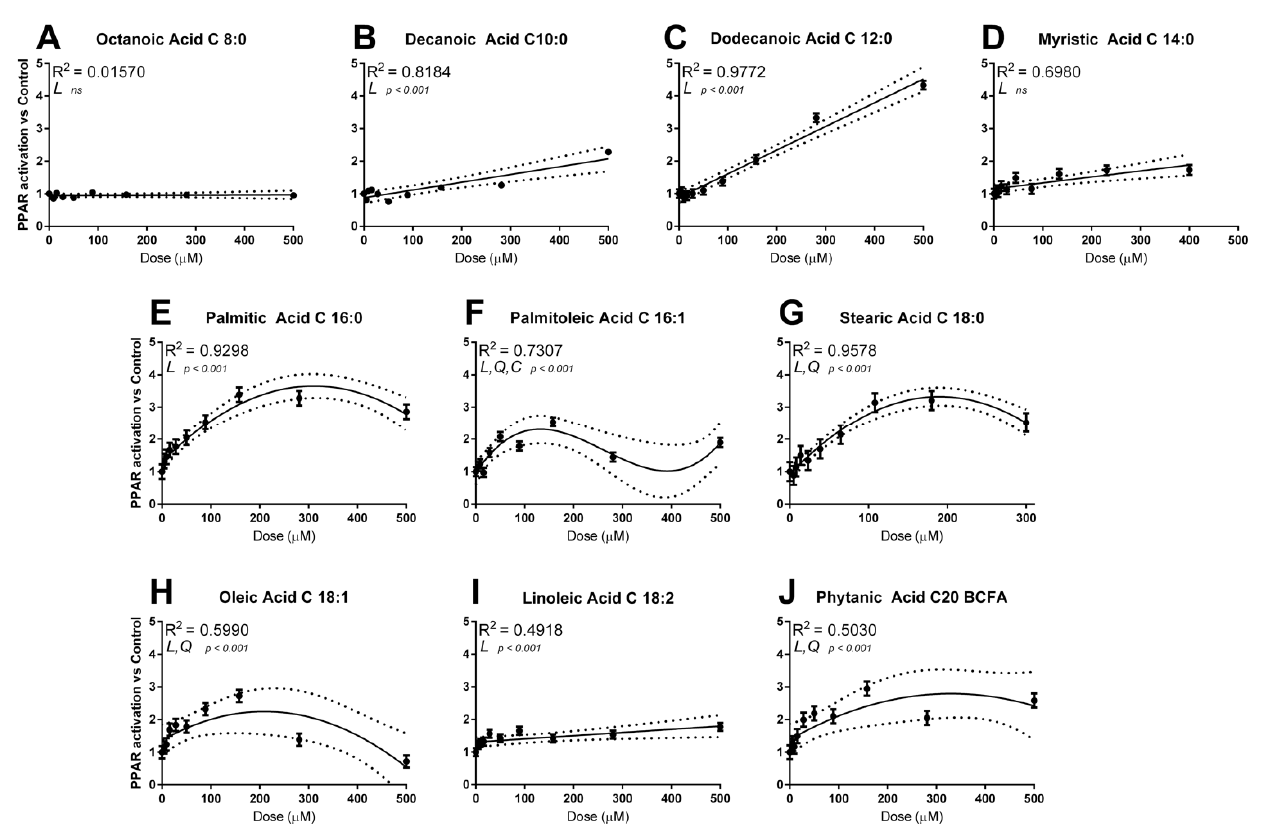
Figure 1. Activation of the PPAR reporter at specified doses of fatty acids octanoic acid ( A ), decanoic acid ( B ), dodecanoic acid ( C ), myristic acid ( D ), palmitic acid ( E ), palmitoleic acid ( F ), stearic acid ( G ), oleic acid ( H ), linoleic acid ( I ), and phytanic acid ( J ). Shown in each graph: significance level of the model (L = linear, Q = quadratic, C = cubic) and adjusted R 2 . Interpolations are presented as trend lines surrounded by a 95% confidence interval (dotted lines).